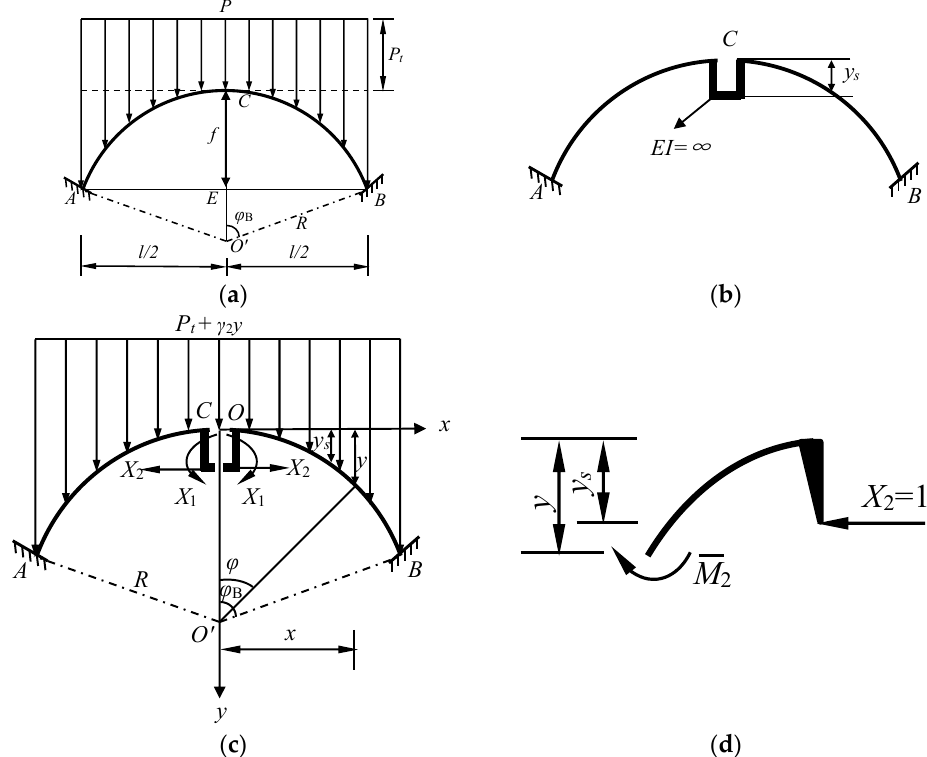
Figure 4. Unhinged arch model based on elastic center method: ( a ) unhinged arch calculation diagram of the arch ring; ( b ) equivalent unhinged arch with rigid arms; ( c ) basic system with rigid arm; and ( d ) force diagram of the isolated part.